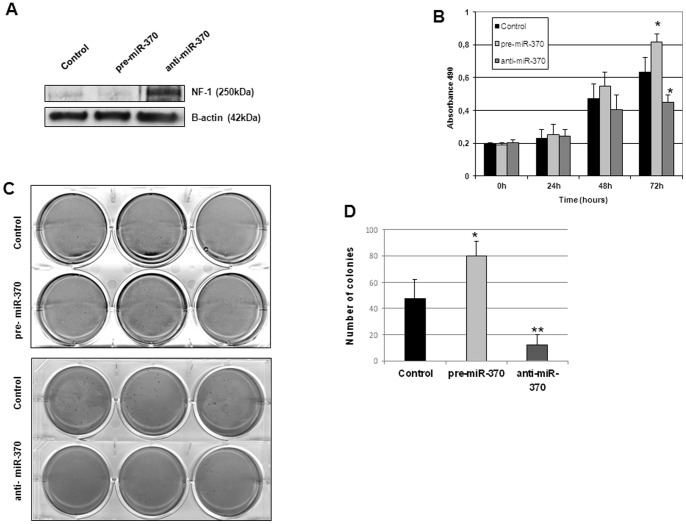
Effects of miR-370 on AML cell proliferation.(A) NF1 expression after transfection with pre-miR-370 and anti-miR-370 in TF-1 cells. (B) Cell growth of TF1 cells after transfection with pre-miR-370, anti-miR-370 or miR-Control. Bars represent the mean ± SD of three independent experiments. *P<0.05 determined using t-student test. (C) Colony forming ability of TF-1 cells transfected with miR-Control, pre-miR-370 or anti-miR-370. Bars represent the mean ± SD, experiments were done in triplicate. *P<0.05 determined using t-student test.